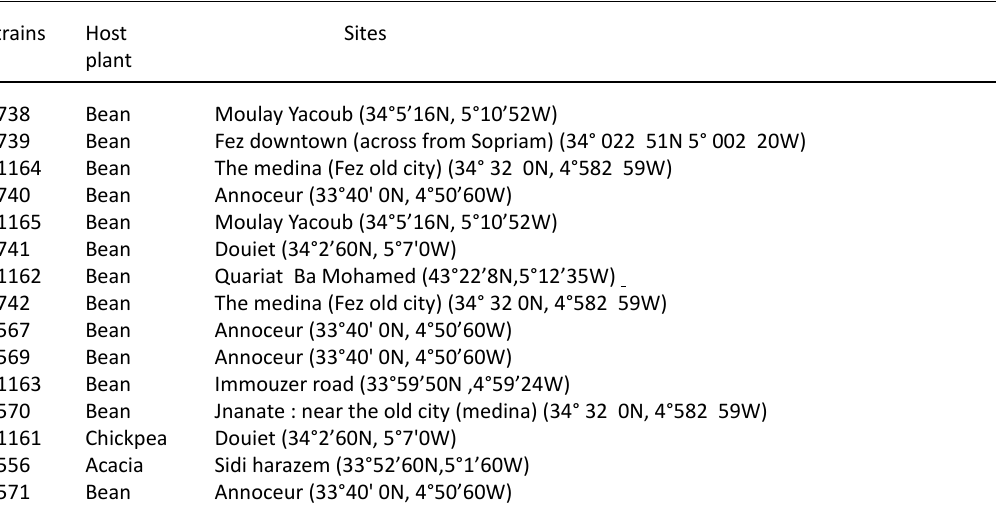
N.B. Strains codes and abbreviations correspond to their identification in the CCMM